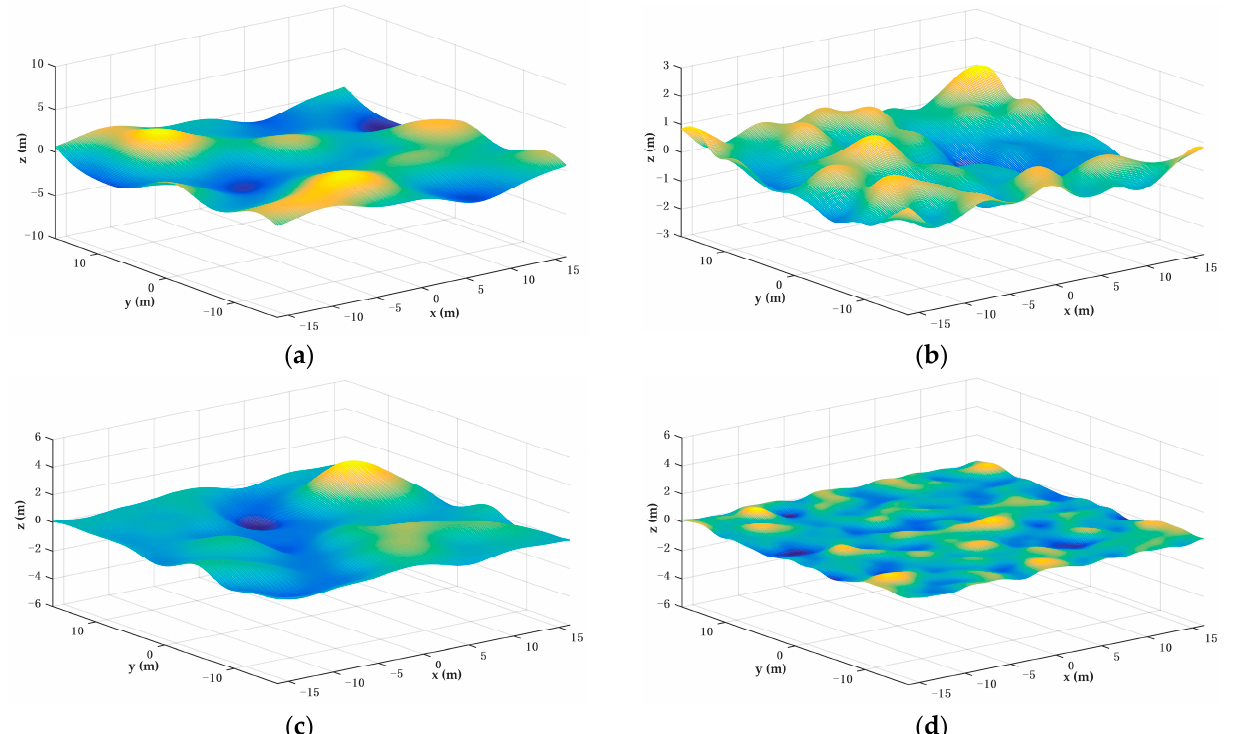
Figure 4. Outline diagram of four different rough grounds. ( a ) Sandy-fleshed ground; ( b ) Silty fertile ground; ( c ) Powdery sandy loam ground; ( d ) Powdery clay ground.